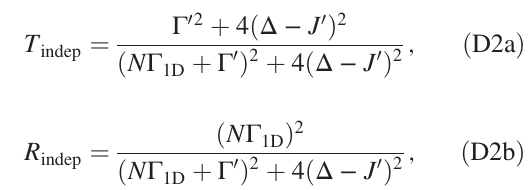
FIG. 21. Linear optics for a chain of N ¼ 20 atoms coupled to a nanofiber, in the mirror configuration ( k 1 (b) reflectance, and (c) loss probability as a function of the atom-probe detuning, within the collective (blue curves) and independent emission (red curves) models. (d) Spatial profile of the excited-state population (in arb. units) at two different detunings, as indicated by the arrows in (c). The green circles have been rescaled for the sake of clarity. The parameters characterizing the nanofiber are given in Fig.